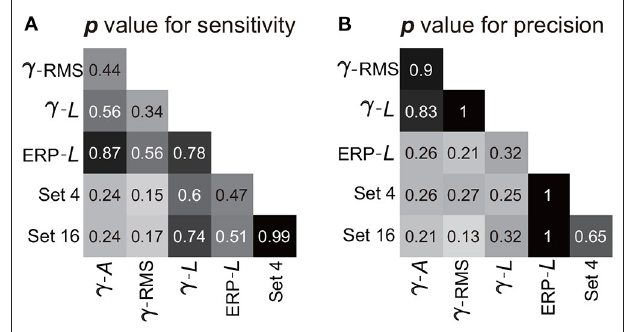
FIGURE 10 | Statistic results of comparisons among features. Panels (A,B) exhibit the p -value of the Mann–Whitney U -test for the sensitivity and precision, respectively. Pairwise comparisons were performed among the features (or feature combination), where the crossover point of the row and column indicates the p -value between the corresponding two features (or feature combination). The symbols for features ( γ , β , α , A , and L ) are the same as those in Figure 9 . Set 4 indicates the four-type feature combination, and Set 16 indicates the 16-type feature